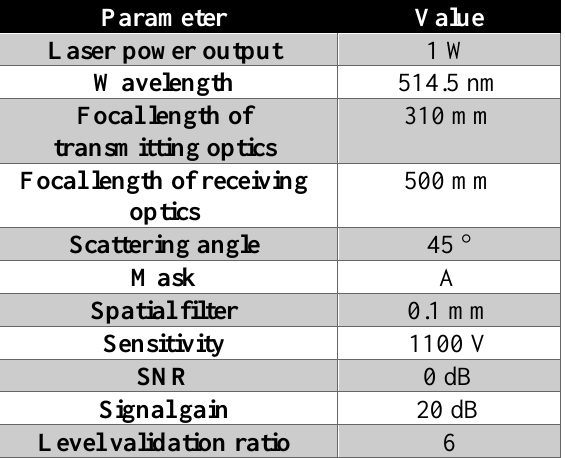
Table 1. PDA experimental setup .